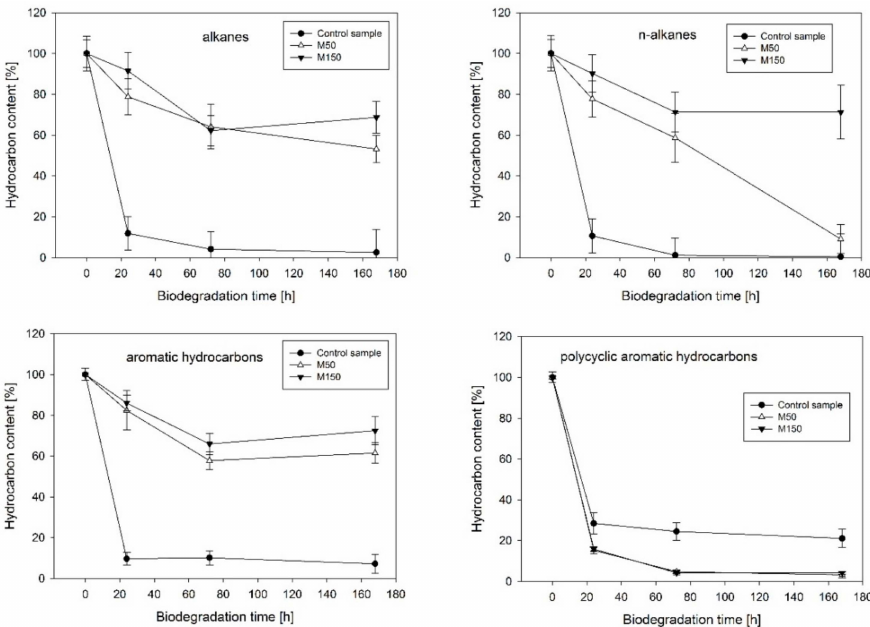
Figure 1. Kinetics of biodegradation of the selected hydrocarbon fractions under the presence of heavy metals (M50 and M150 correspond to 50 mg · L − 1 and 150 mg · L − 1 , respectively).